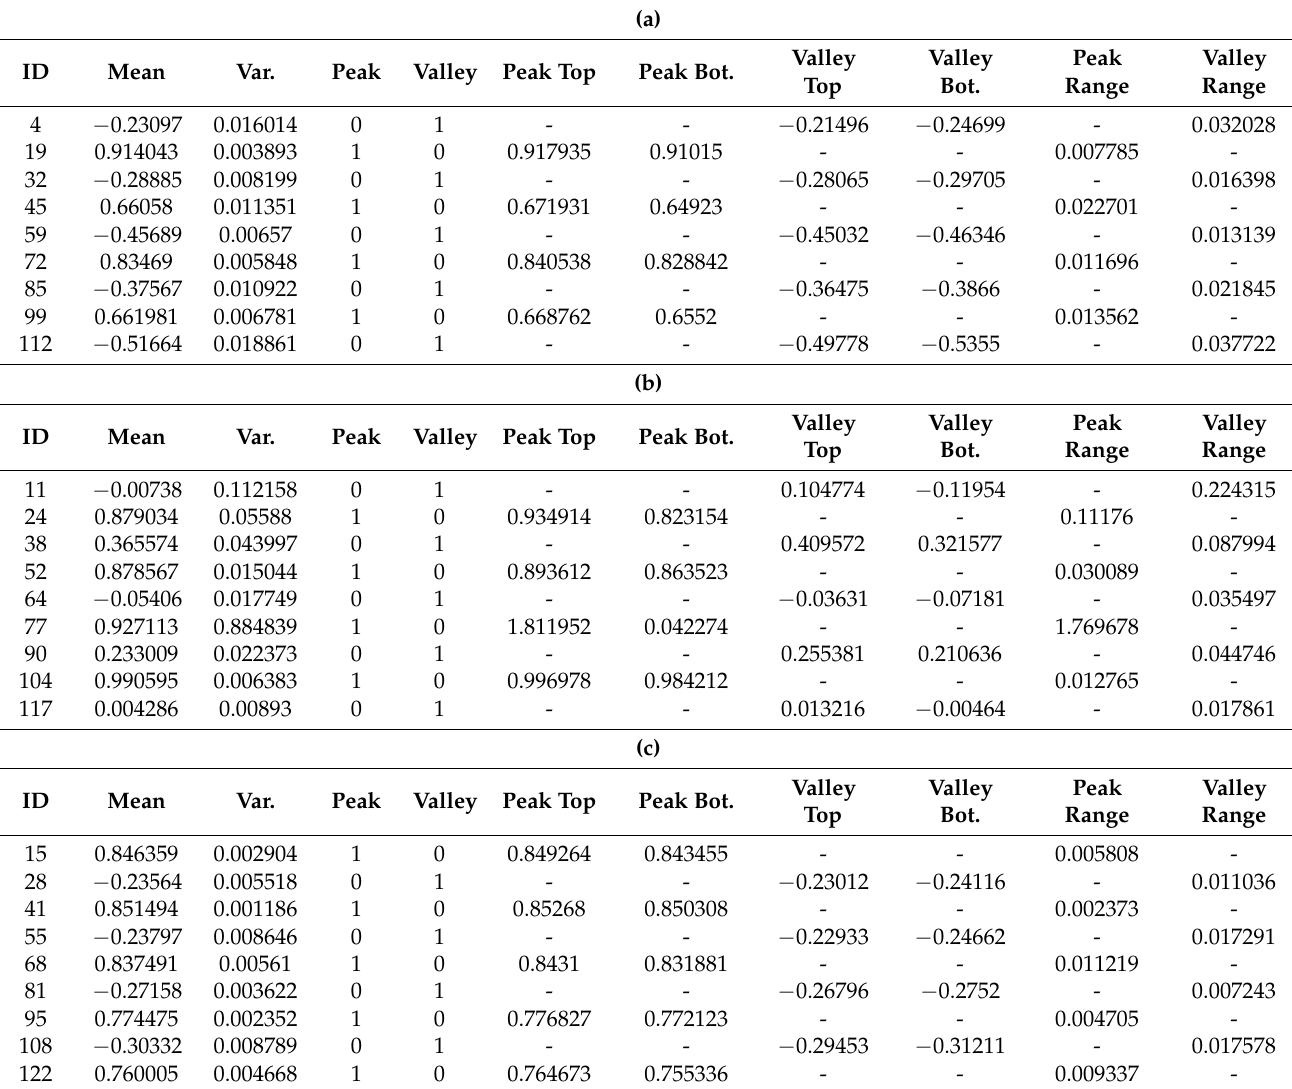
Table 1 digests how the first rule was established in Section 4.1, based on the resampled, resmoothed, and mean–var. transformed data on the X axis (see Section 3.3 and Figures A7a, A8a and A9a), with the setting that wind-speed (WS) = 6 m/s. Table 2 is numerically presented on the Y axis (see Section 3.3 and Figures A7b, A8b and A9b), because rule 1 says that using the information either on the X-axis or on the Y-axis is okay. Table 1. Resampled, resmoothed mean–var. transformed data on the X axis (WS = 6 m/s). ( a ) Min/var. peak/valley Stats for the 3.0-blade turbine. ( b ) Min/var. peak/valley stats for the 2.5-blade turbine. ( c ) Min/var. peak/valley stats for the 2.0-blade turbine.